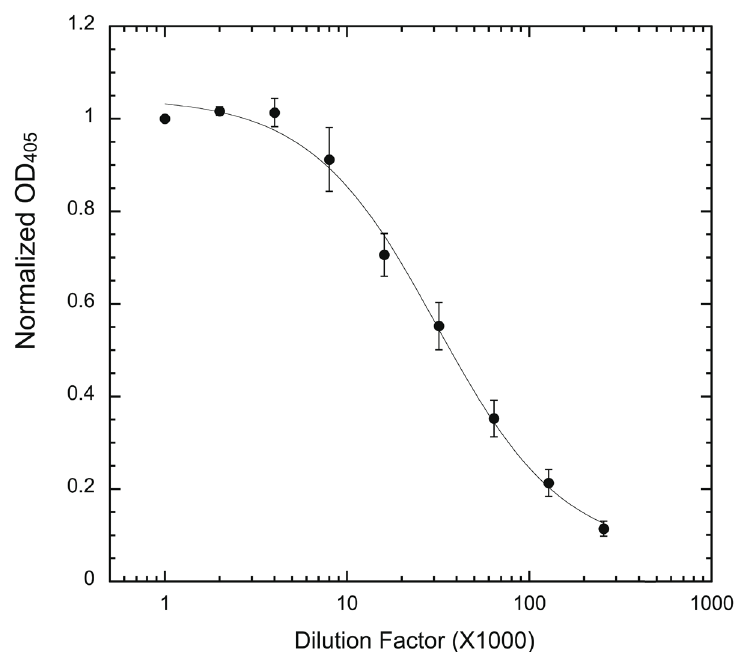
Figure 5. 3D3 dilution factor determination. Wells were coated with 200 ng/well HT-PRD and then subjected to phosphorylation with 5 ng HT-497 under the standard reaction conditions. 3D3 to be tested was serially diluted (from 1000 to 256,000x) and used to probe the phosphorylated wells, followed by secondary antibody as described. Normalized OD (n = 9 for each data point).